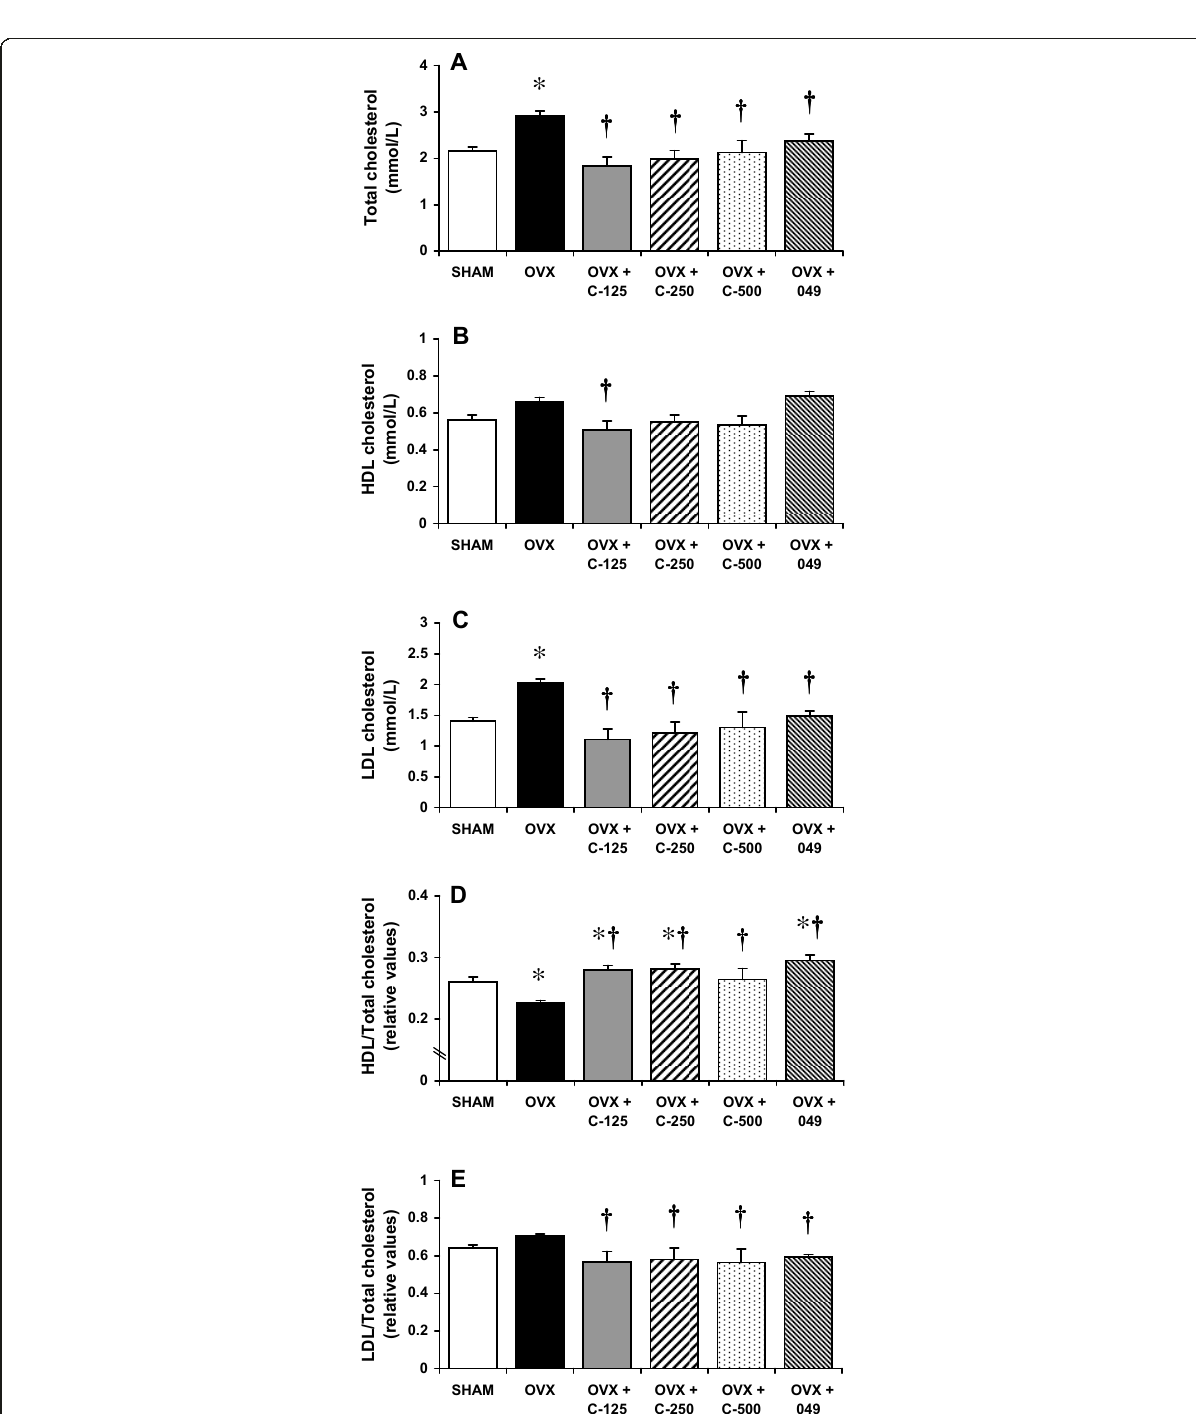
Figure 3 Serum lipid levels of sham operated control (SHAM) and ovariectomized (OVX) rats treated with or without C. comosa hexane extract or compound 049 . Animals are as described in legend of Figure 2. (A) total; (B) high-density lipoprotein (HDL) cholesterol; (C) low-density lipoprotein (LDL) cholesterol; (D) ratio of HDL to total cholesterol (HDL/total); and (E) ratio of LDL to total cholesterol (LDL/total). Values are reported as the mean ± SE for 8 animals/group. * P < 0.05 vs. SHAM group; † P < 0.05 vs. OVX